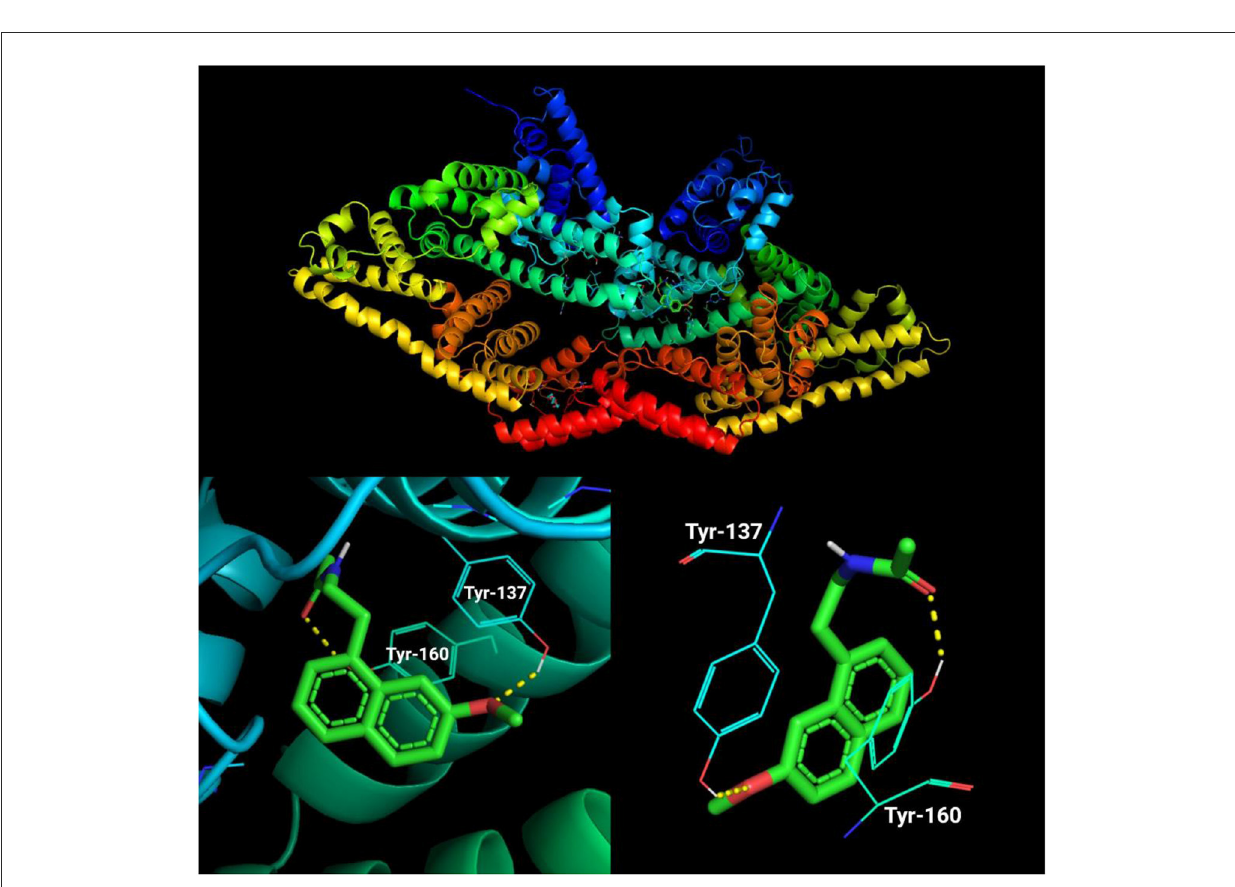
FIGURE10 Visualization of an agomelatine docking site (mode 1) in a BSA